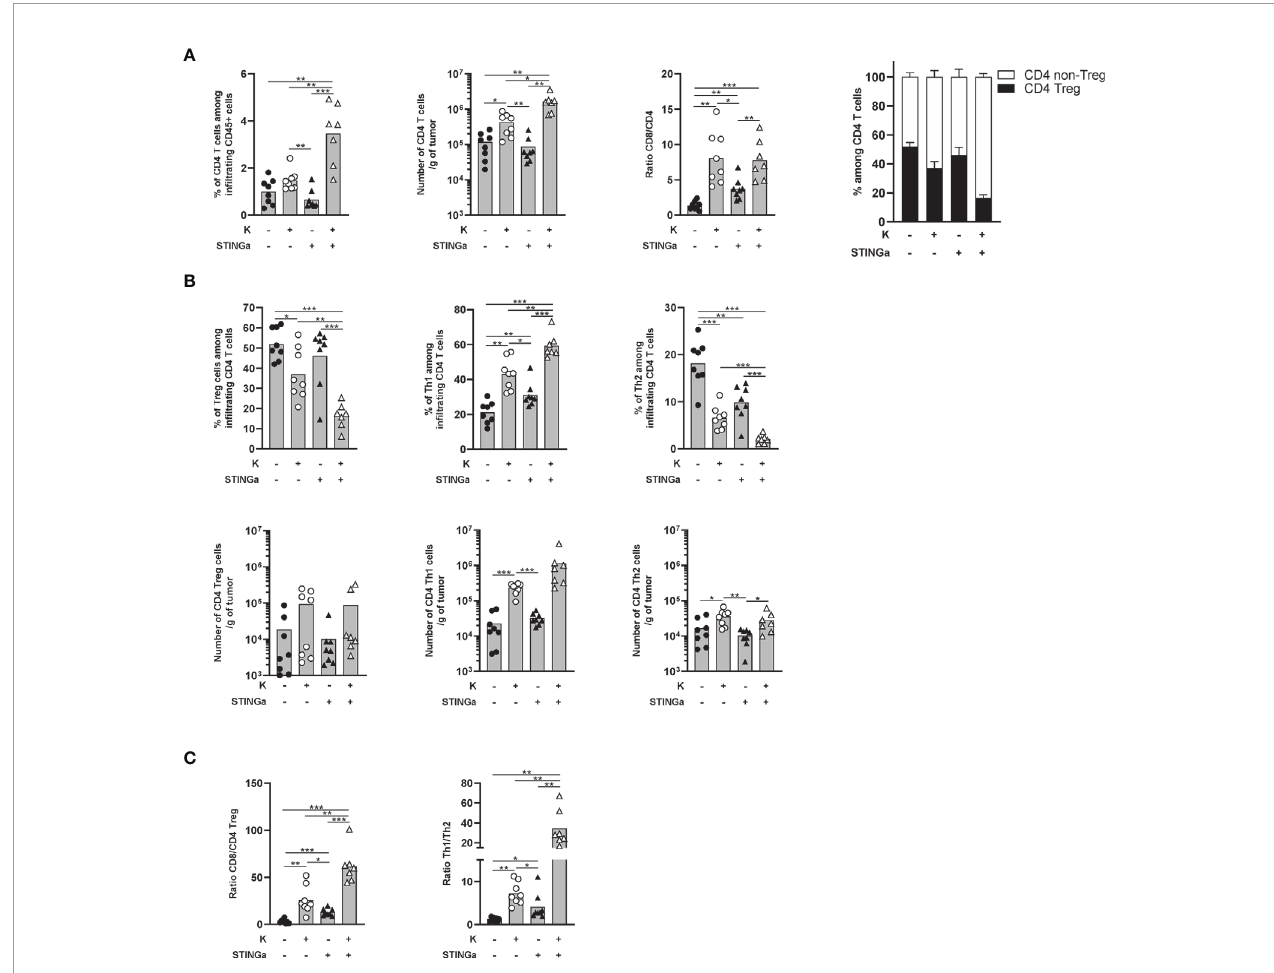
FIGURE 5 | Combination of protein vaccine with STING agonist positively modulates the polarization of intra-tumoral CD4 T cells in TC-1 model. 10 5 TC-1 cells were implanted on the back of C57BL/6 mice. When tumors were visible, mice were treated with two administrations of KISIMA vaccine, STING agonist, or a combination of the two at one-week interval. One week post the last treatment, mice were sacri fi ced, tumor harvested, and CD4 T cells ’ presence and phenotype were analyzed by FACS staining. (A) Frequency and number of total CD4 T cells among tumor in fi ltrating leukocytes, ratio between tumor in fi ltrating CD8 T cells and CD4 T cells, frequency of Treg and non-Treg among tumor in fi ltrating CD4 T cells. (B) Frequency (top) and total number normalized to tumor weight (bottom) of Treg, Th1, and Th2 among tumor in fi ltrating CD4 T cells. (C) Ratio between tumor in fi ltrating CD8 T cells and CD4 Treg cells, and between Th1 and Th2 tumor in fi ltrating CD4 T cells. (A – C) A pool of two experiment is shown (n ≥ 7/group), Mann – Whitney test , *p < 0.05, **p < 0.01, ***p <